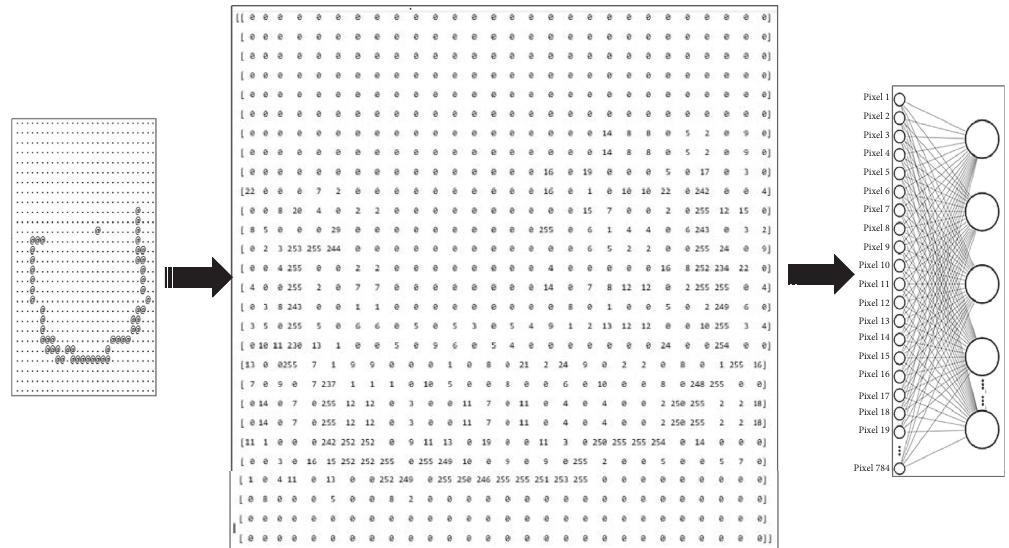
Figure 5: Image representation for the neural network.